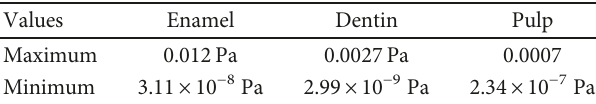
Table 3: Control case: von Mises stresses results.